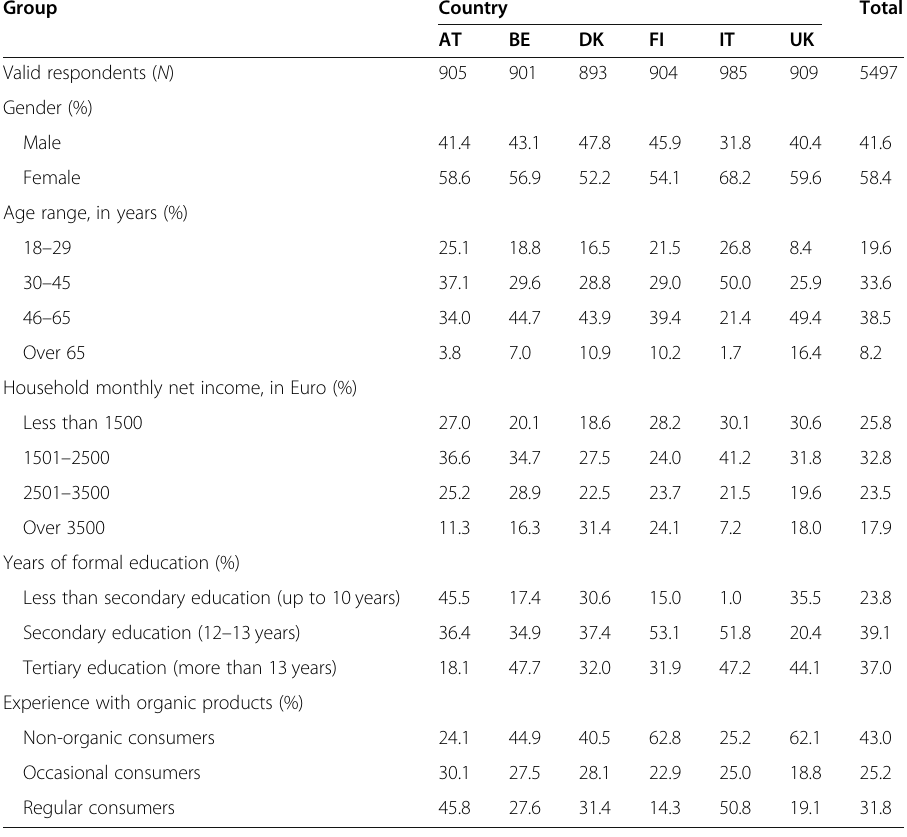
Table 2 Description of the sample